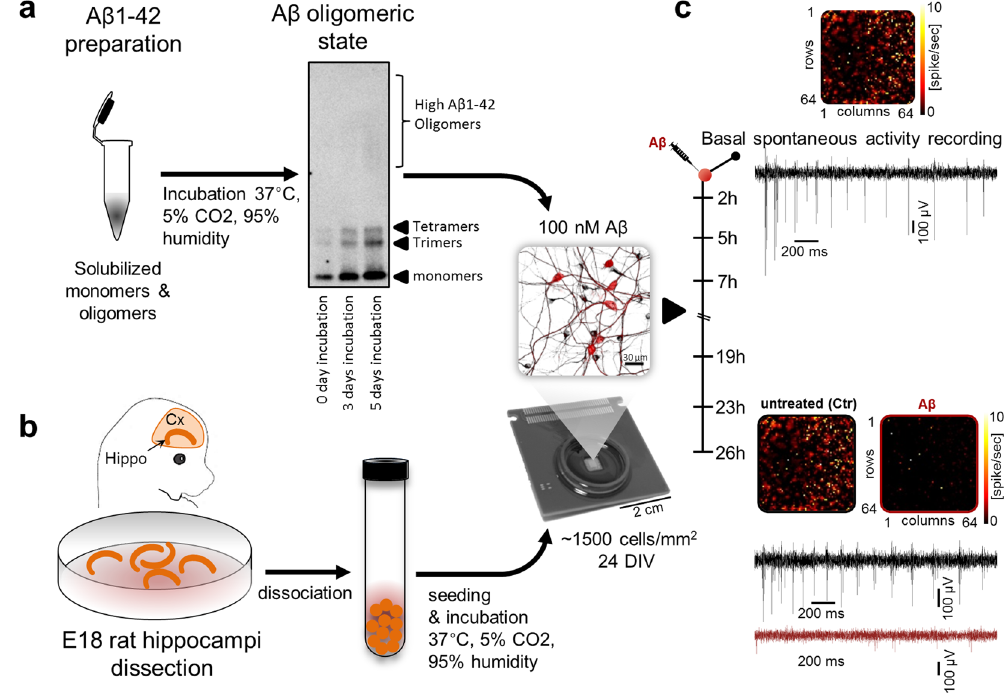
Figure 1. Schematic illustration of the experimental neurodegeneration model on-CMOS-MEA chips. ( a ) Preparation and optimization of A β -oligomers. ( b ) Preparation and seeding of embryonic hippocampal neurons on CMOS chips. ( c ) Monitoring the spontaneous firing activity from 4096 electrodes on CMOS chips at baseline and after 0.1 µ M A β -oligomer